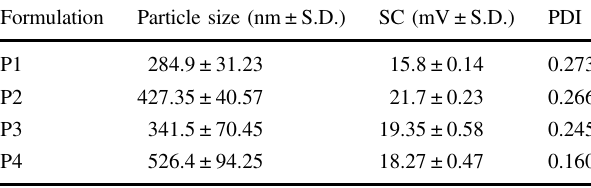
Table 2 Particle size and SC of formulations P1 to P4